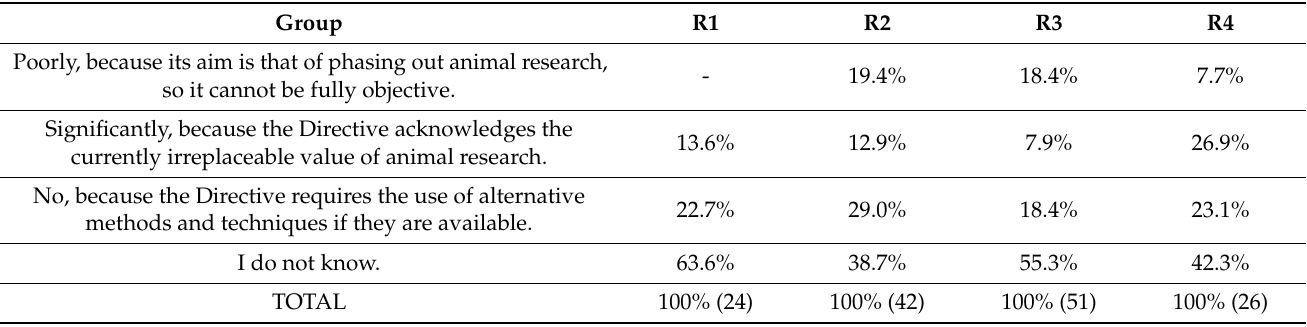
Table 2. Participants answered the following question “If an animal model and a new